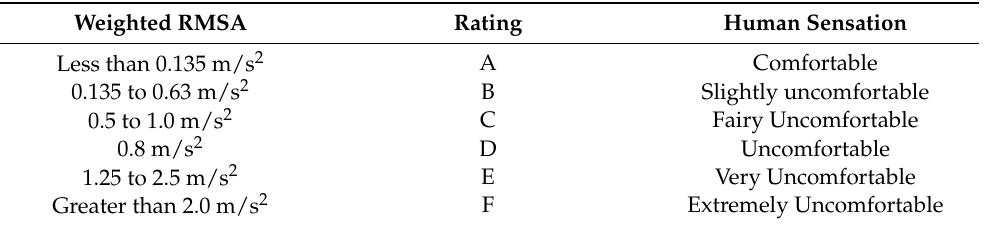
Table 1. Comparison of root-mean-square acceleration (RMSA) and human sensation according to ISO 2631-1997 [14].